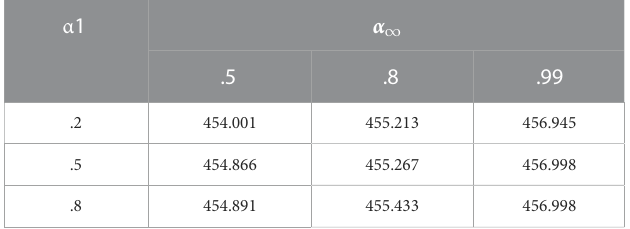
TABLE 5 The results of Comparison under different con fi dence intervals.